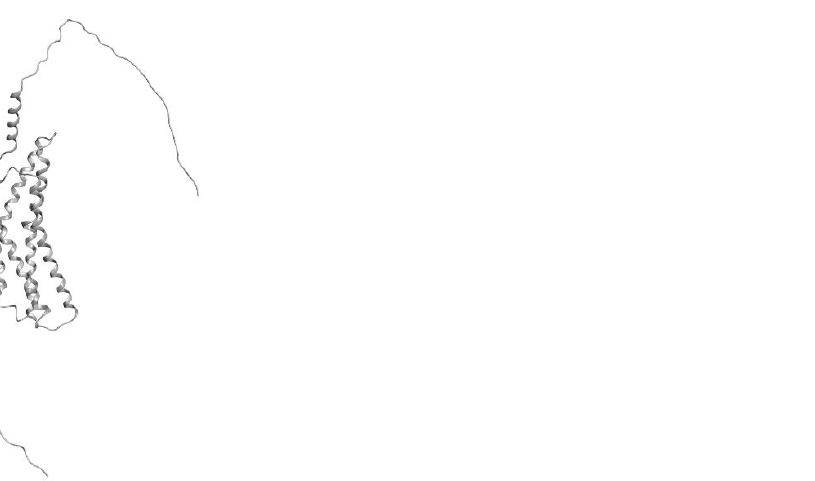
Figure 17. Representation of the structure of the adrenergic β 2 receptor (sourced from the Protein Data Bank, PDB code: 7DHI [129], method: cryo-EM, resolution: 3.26 Å ). The image was created and rendered with MOE. 2.8. Histamine Receptors Histamine receptors represent a group of class AGPCRs thathas attracteda lot of in- terest inthe pharmaceutical world in recent decades. This family is composed of four dif- ferent members (H 1 , H 2 , H 3 , and H 4 ), each with a specific localization in the organism. Their functions, vary from one isoform to another, ranging from vasoconstriction (H 1 ) to gastric acid secretion (H 2 ), to neurotransmitter release (H 3 ), to immunoregulation (mainly H 2 and H 4 ) [130]. For each histamine receptor, the research has mainly focused on the mechanism of antagonism, of which several marketed drugs are still now relevant exam- ples (e.g.,Cetirizine, Figure 18, panel A, for H 1 antagonism; or Famotidine, represented in Figure 18, panel B, for H 2 blockage) [131].